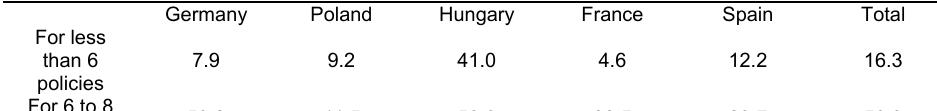
Table 5: Correspondence of regio-crats’ preferences with functional needs 23